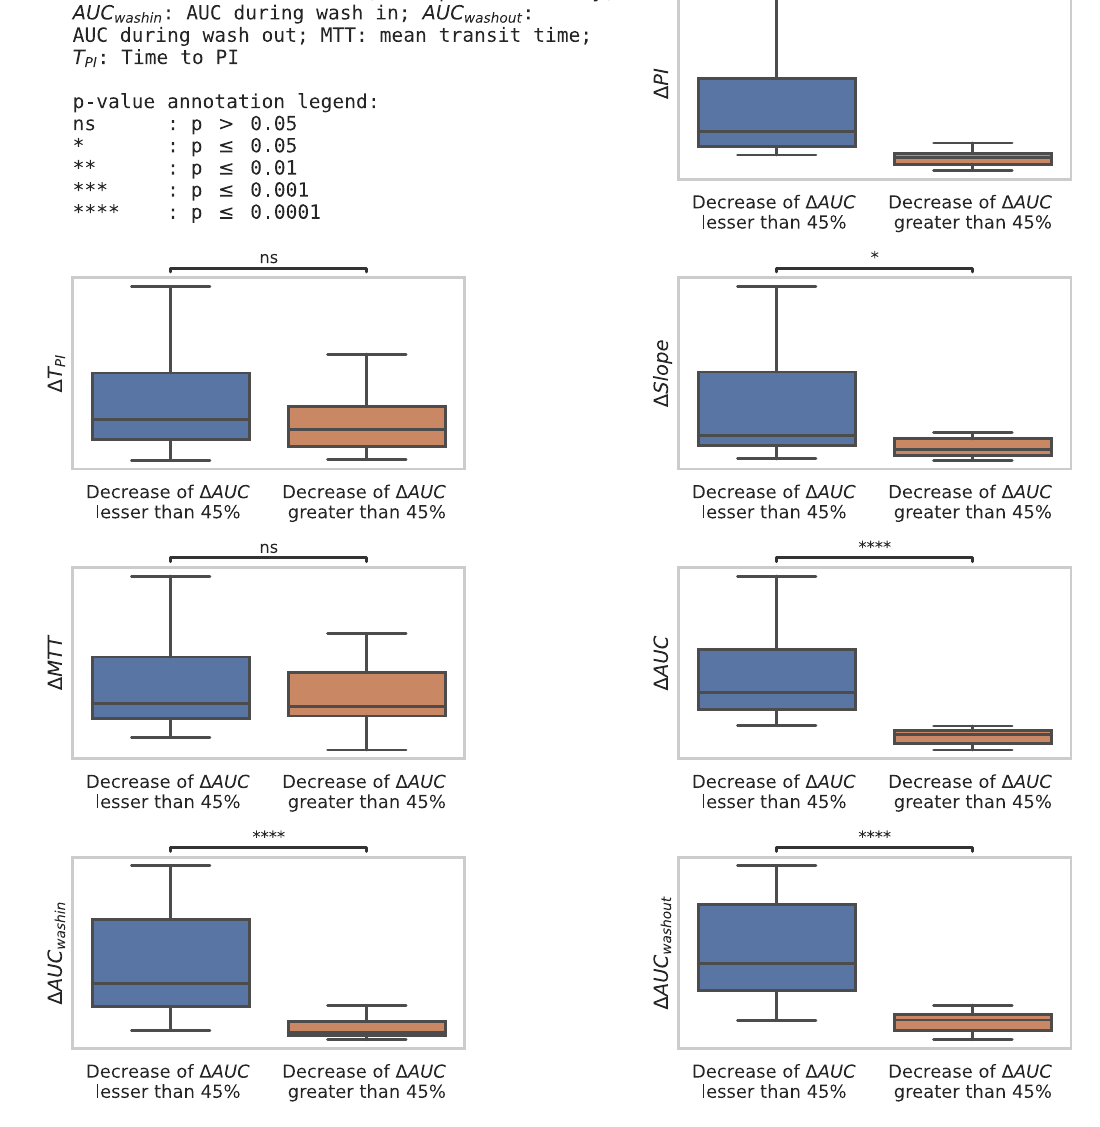
Figure 6. Box plot representing the change in perfusion parameters from baseline to D21 in the group of a decrease in ∆ AUC lesser than 45% ( n = 33 patients) vs. in the group of a decrease in ∆ AUC greater than 45% ( n = 20 patients).